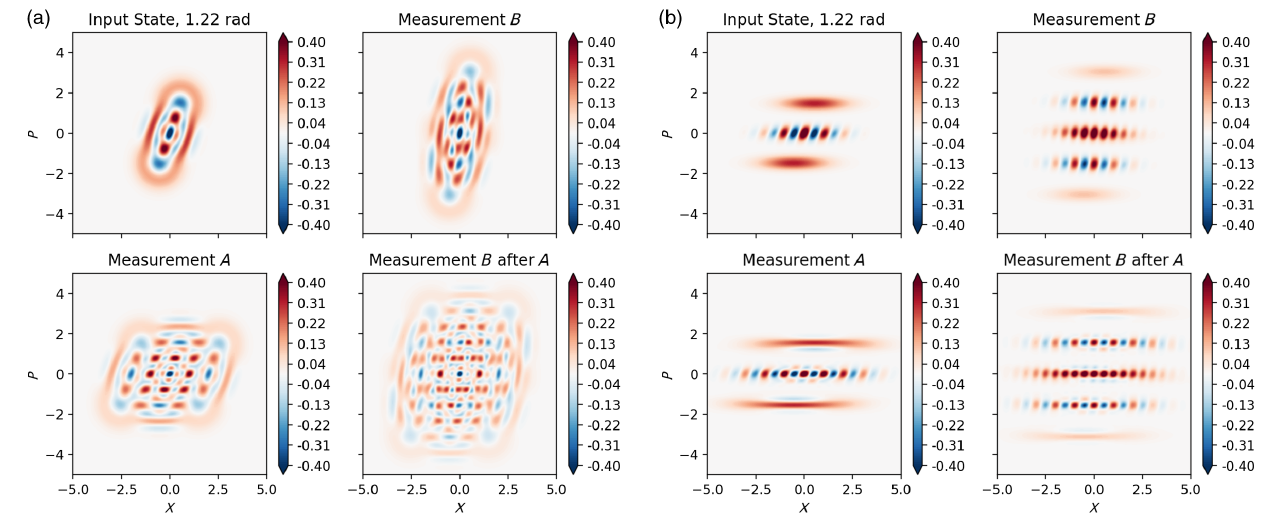
FIG. 7. Theoretical Wigner function plots of two more examples of input states for the measurements presented in Fig. 3 of the main ˆ D ˆ D text. The displayed input states are ( ð − j α B j e i ϕ I = 2 Þ þ ðj α B j e i ϕ I = 2 Þ ) j ϕ i with ϕ I ¼ 1 . 22 rad and (a) j ϕ i ¼ j 1 i and (b) Further, their post-measurement states with the result þ 1 during the experimental sequence are